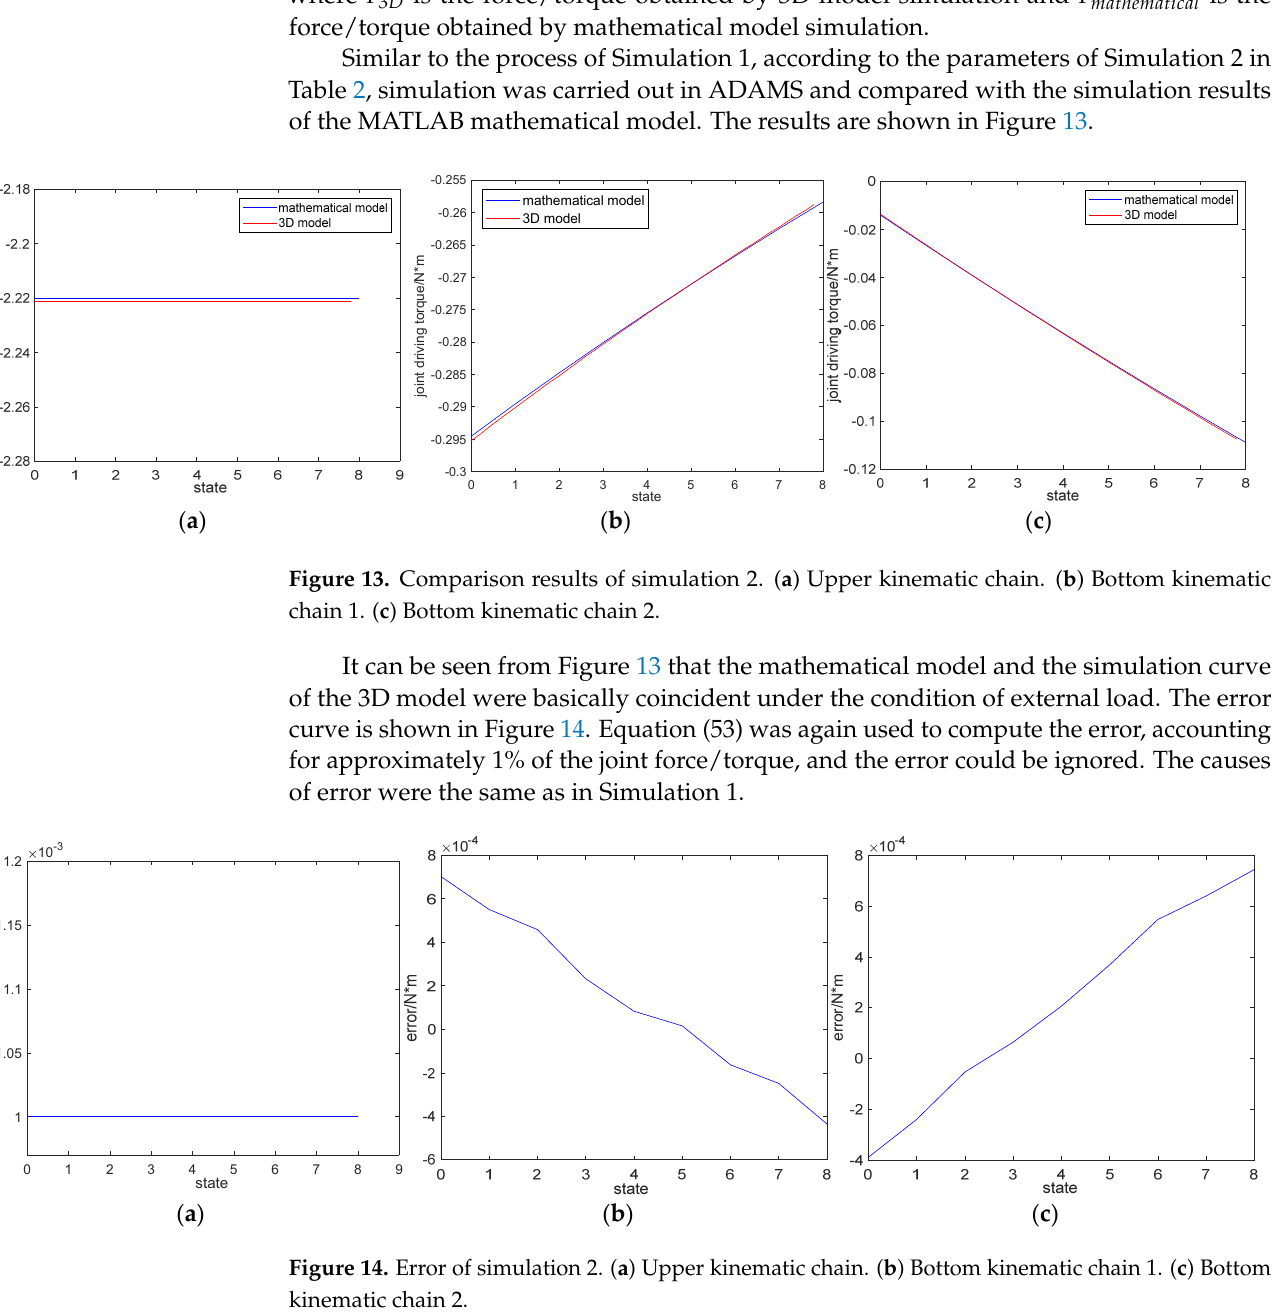
( c ) Figure 12. Error of simulation 1. ( a ) Upper kinematic chain. ( b ) Bottom kinematic chain 1. ( c ) Bottom kinematic chain 2. It can be seen from Figure 12 that the magnitude of output error is 0.001 N, and the magnitude of torque error is 0.0001 N ∙ M. The influence of error on the actual force/torque can be more intuitively observed by considering the error as a percentage. Therefore, we used Equation (53) to compute the percentage of error in the joint force/torque. The error was approximately 1%, and therefore can be ignored, which also verifies the correctness of the static force model. According to detailed analysis, the simulation error was mainly composed of two parts. One was the error introduced by parameters measured in Solid-